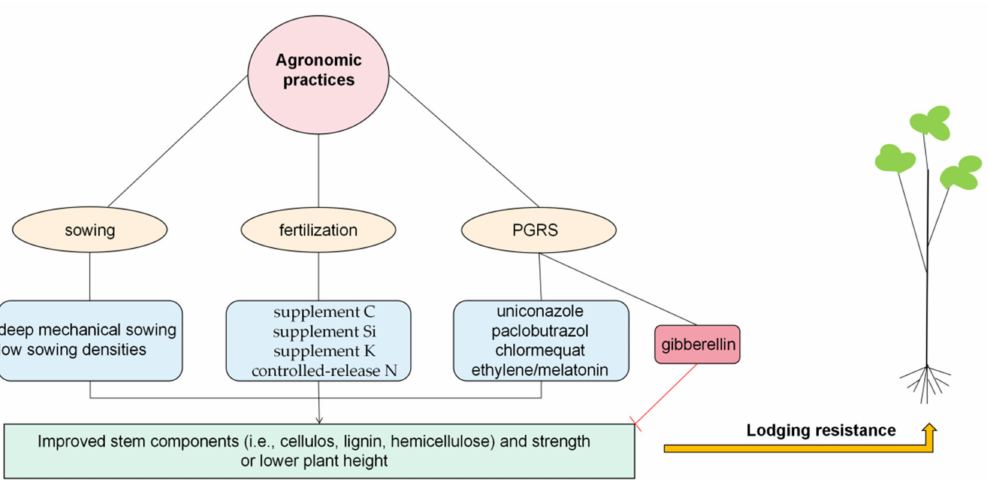
Figure 2. Agronomic practices affect stem components to resist lodging. All arrows indicate improve- ment. The red line represents suppression. PGRs—plant growth regulators. C, Si, K and N refer to carbon, silicon, potassium and nitrogen fertilizers,